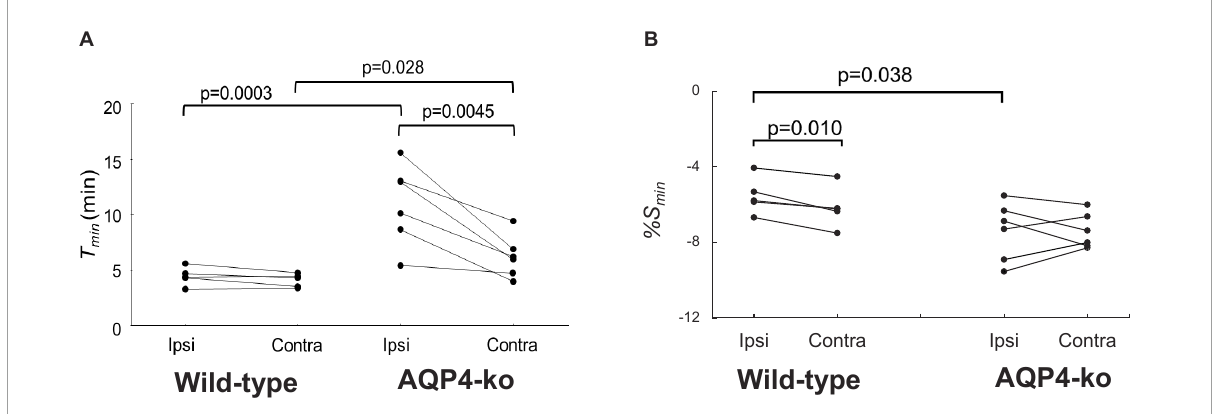
FIGURE3 Comparisons of the time-to-min ( T min ) and signal minimum ( %S min ) in the anterior cerebral artery (ACA) regions-of-interest (ROIs) after deuterium-labeled water (D 2 O) administration. (A) T min for the wild-type ( n = 5) and AQP4 knockout (AQP4-ko) ( n = 6) mice. (B) %S min for both mouse genotypes. Results for the same animal are connected by lines. Comparisons between genotypes were made using an unpaired t -test, while the comparison between the ipsi and contralateral sides were made with a paired t -test. The resulting p values are shown at the top of the figure. Note that, although the data from five the wild-type mice are plotted, the data for two of the animals nearly overlap so that it appears that there is only four data